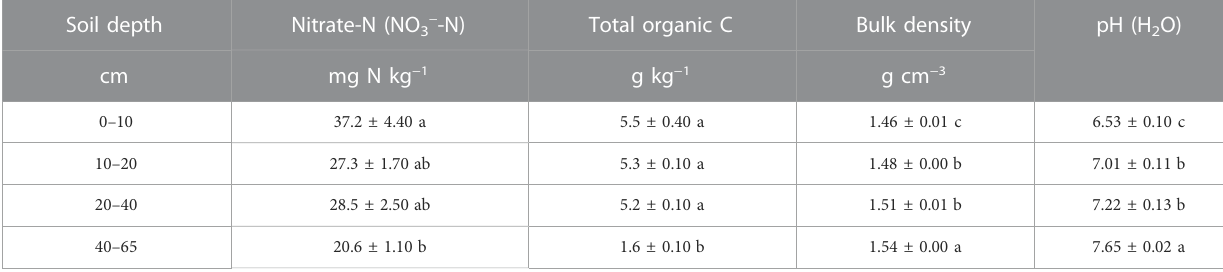
TABLE 1 Soil properties at different layers (0 – 60 cm) of pro fi les before sowing in 2016. Values are means ±1 standard error, n = 4. Soil